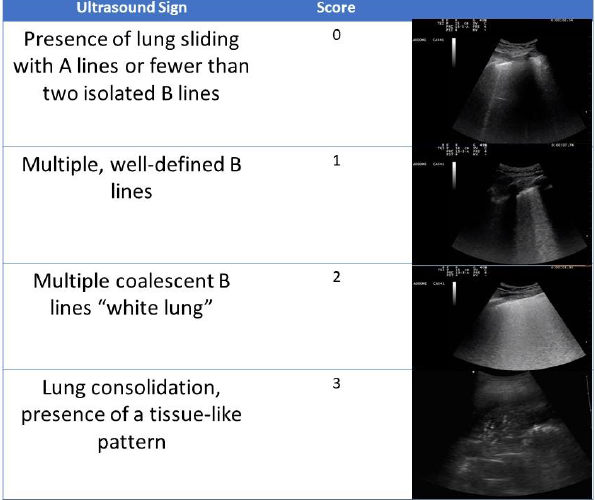
Figure 1. The sum of the number of the 12 examined lung fields provided a final result (LUS score); the LUS score therefore ranged from 0 to 36. The patient was preferentially examined in the sitting position; in case of forced supine position, posterior scans were performed by rolling the patient on their side.